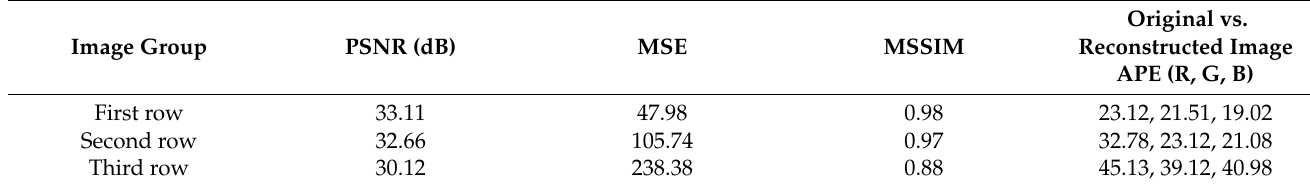
Original vs. Reconstructed Image APE ( R, G, B )